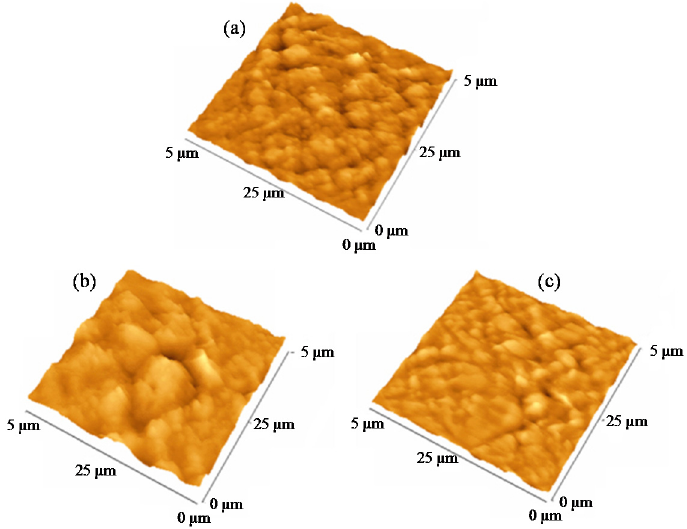
Figure 7. Atomic force microscope (AFM) of top surface of styrene ‐ acrylonitrile ‐ blended PVDF Atomic force microscope (AFM) of top surface of styrene-acrylonitrile-blended PVDF membranes.